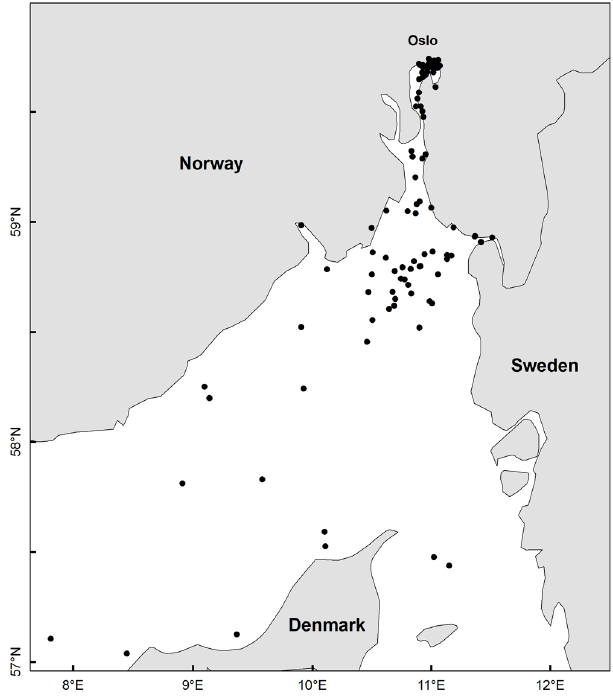
Fig. 1. Locations of the